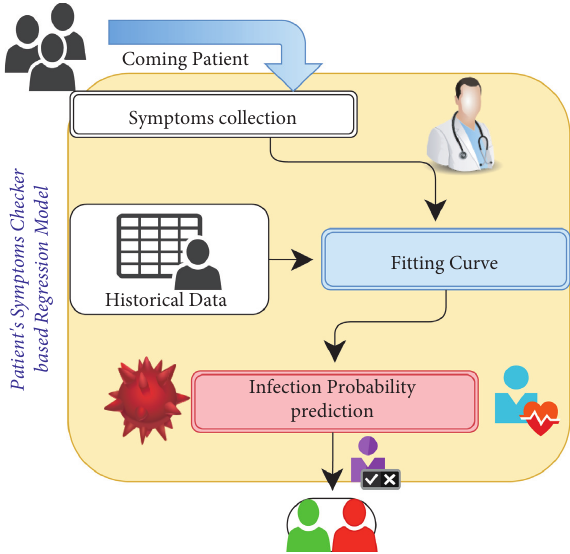
Figure 2: PSC based on regression